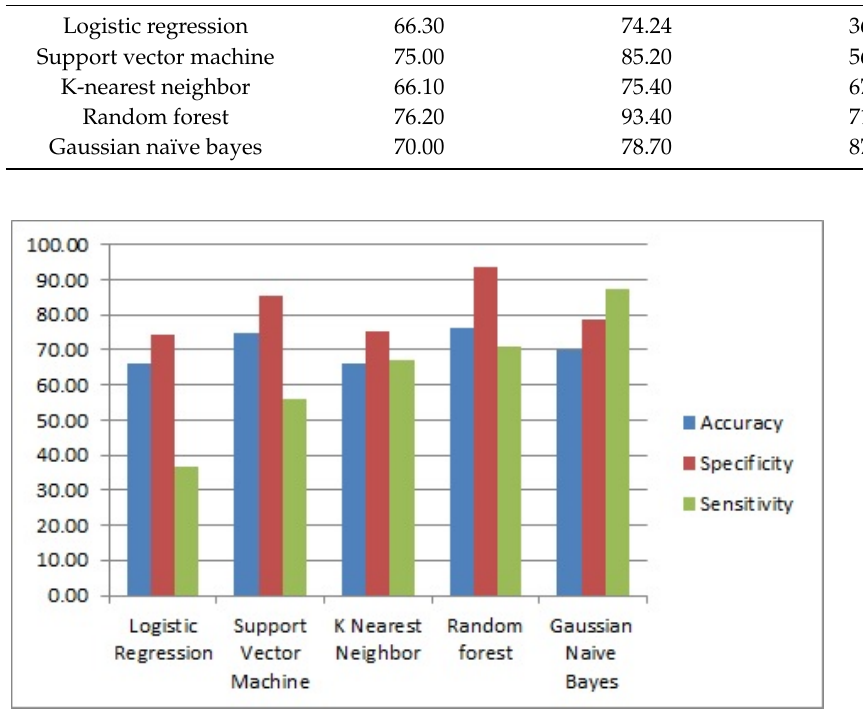
Figure 7. Chart presentation of performance evaluation result of classification models with full fea- tures.